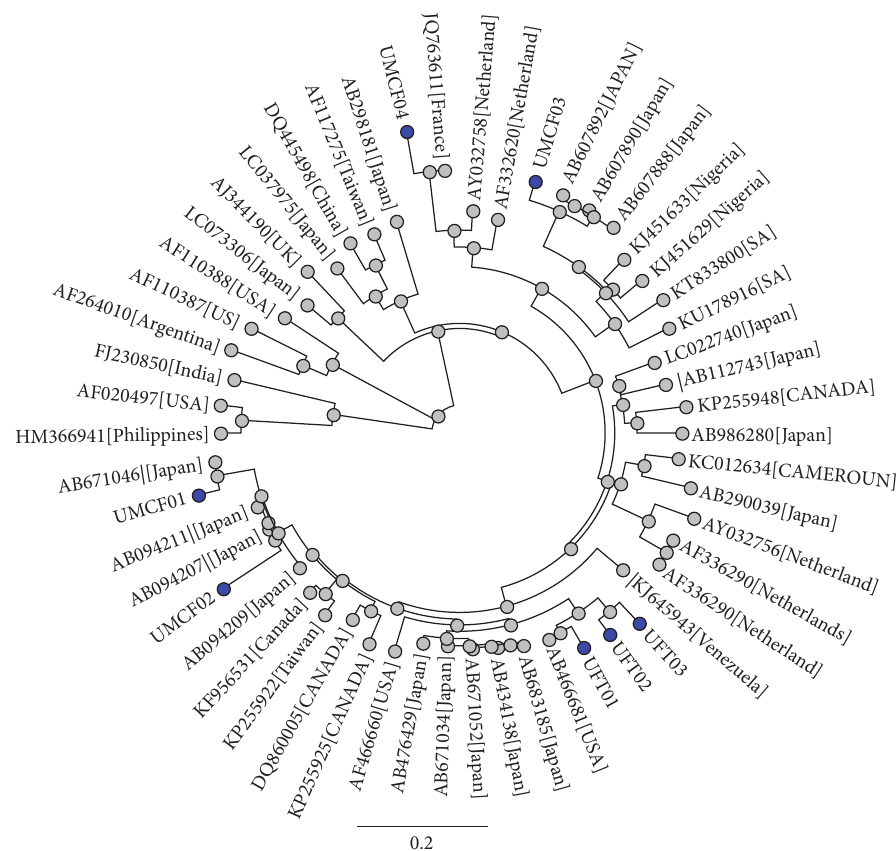
Figure 1: Phylogenetic relationships of HEV isolates obtained in this study. Phylogenetic analysis was based on 300 bp of the ORF 2 gene of the swine HEV isolates obtained in this study along reference sequences of other swine and human HEV strains from different geographical regions of the world that were obtained from the GenBank. Tree was drawn with Geneious R9.1.5 (Biomatters Limited). Sequences obtained in this study are given in blue